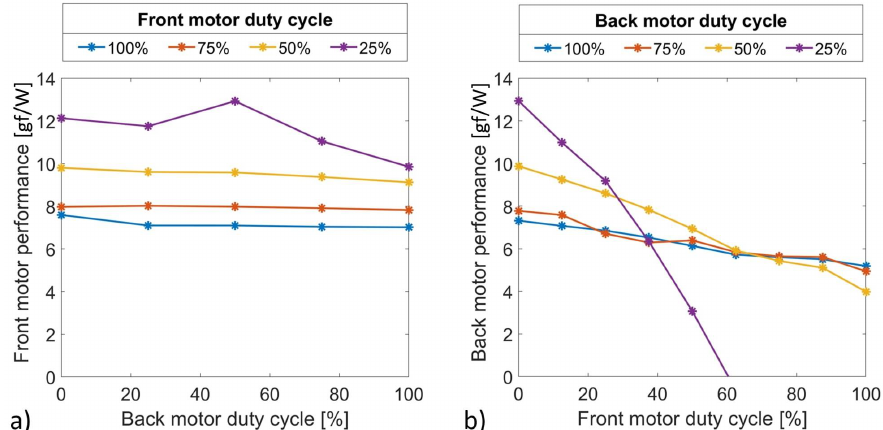
Figure 7. ( a ) Front rotor performance for different back motor duty cycles. ( b ) Back rotor performance values for different front motor duty